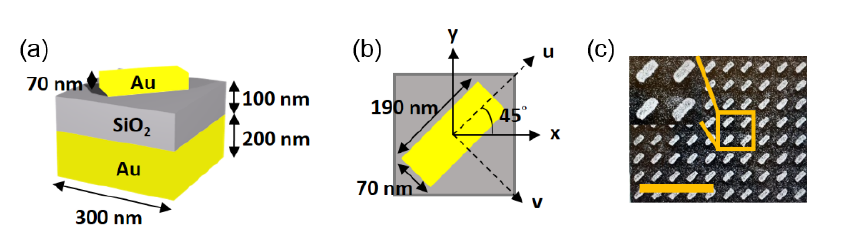
Figure 2. ( a , b ) Schematic of a unit cell of metasurface consisting of an Au-SiO 2 -Au structure. The dashed axes of “u” and “v” define the longer and shorter axes of the nanobrick. The “x” axis defines the CLC director at the surface; it is oriented at χ = 45 ◦ . ( c ) The scanning electron microscopic image (the scale bar is 1.2 µ m). The detailed images of the nanobricks are shown in the inset.